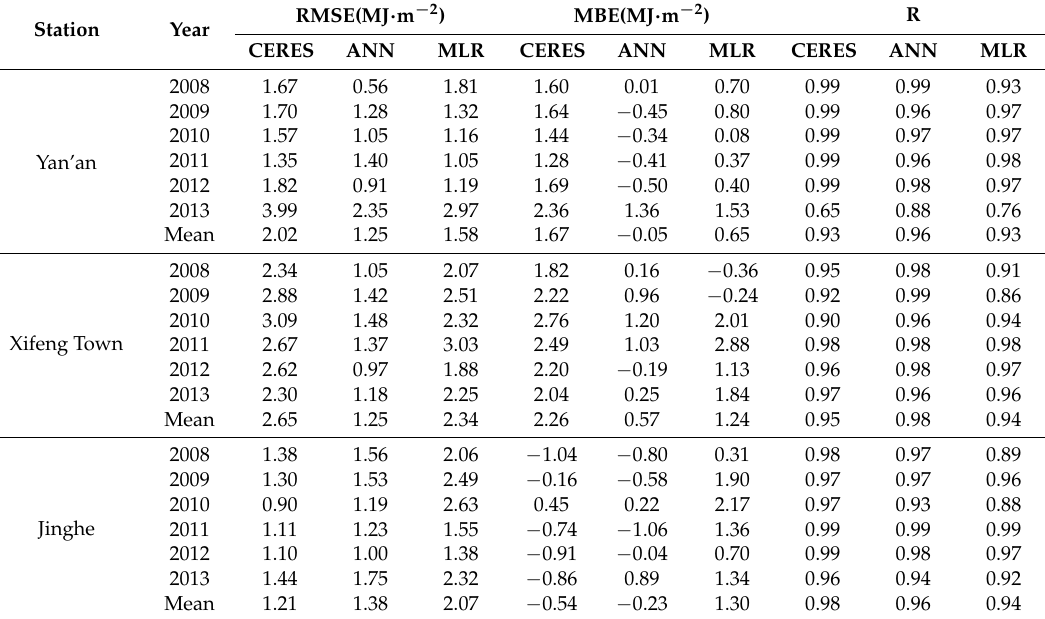
Figure 6. Individual results for 3 validation sites. ( a ), ( b ) and ( c ) are the results of three methods (ANN model, MLR method and CERES radiation products) for Yan’an, Xifeng town and Jinghe, respectively. Table 3. Statistical indicators of the models and CERES.